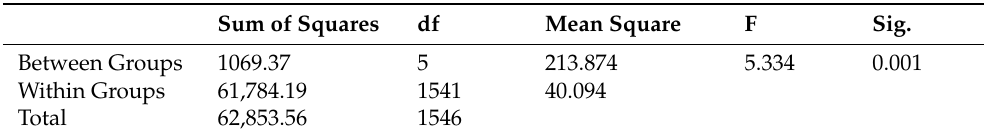
Table 2. One-Way ANOVA Depression